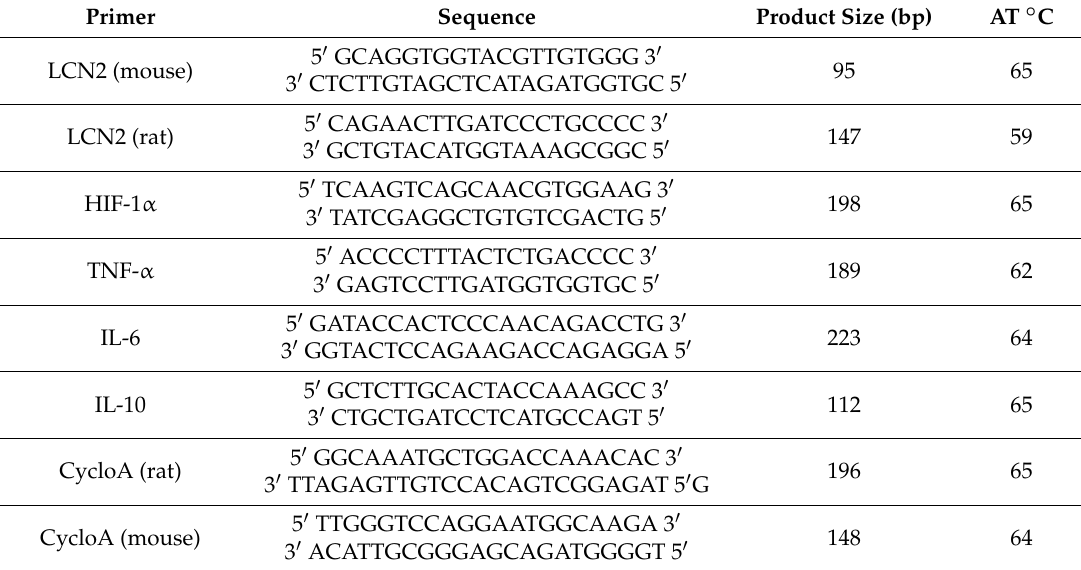
Table 1. List of primers used in the study.